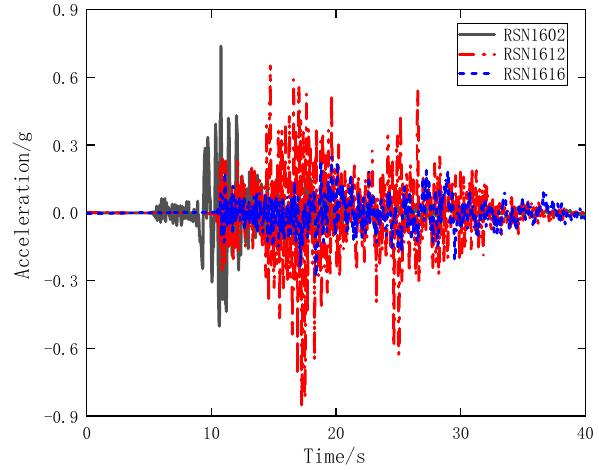
Figure 21. Time-history curve of near-field vibration acceleration.